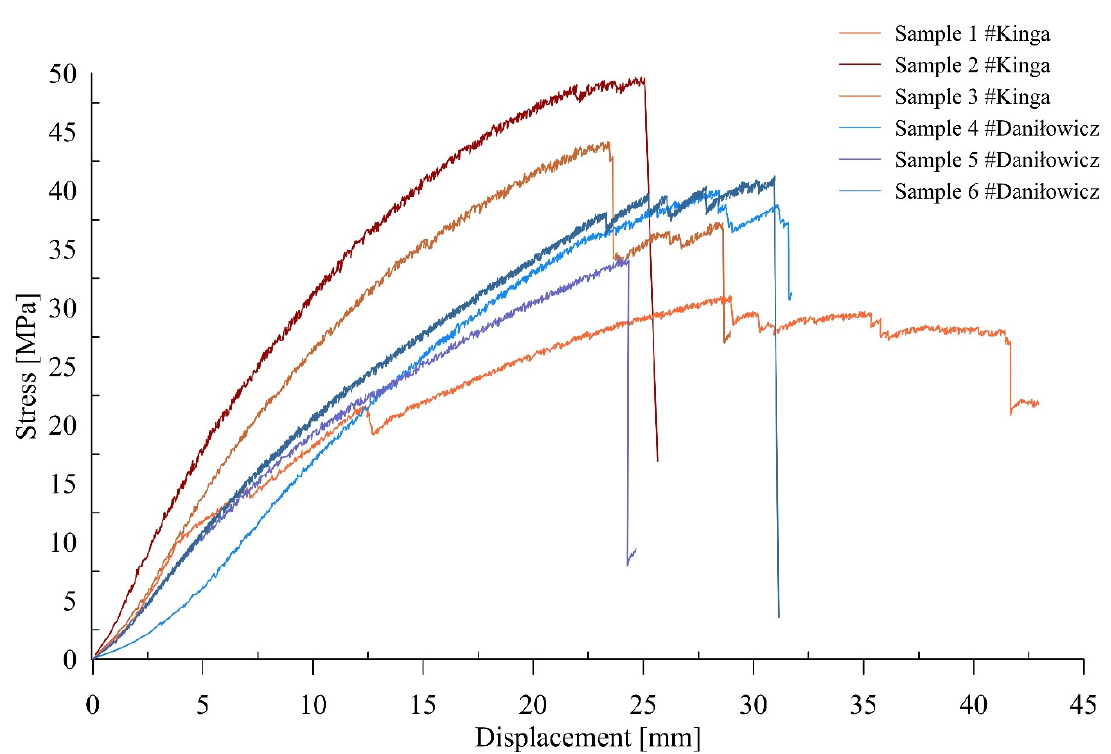
Figure 4. Stress-strain characteristics of samples in flexural strength tests.